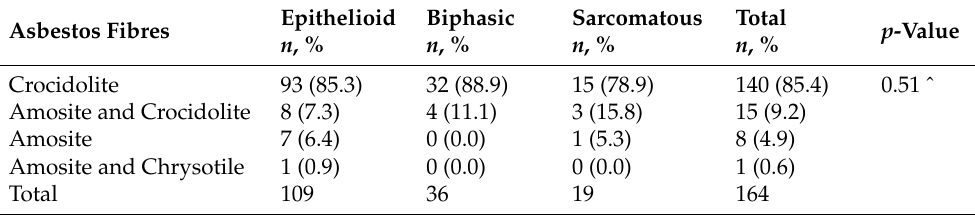
Table 9. Relationship between histological mesothelioma cases by asbestos fibre type and mesothe- lioma subtype.